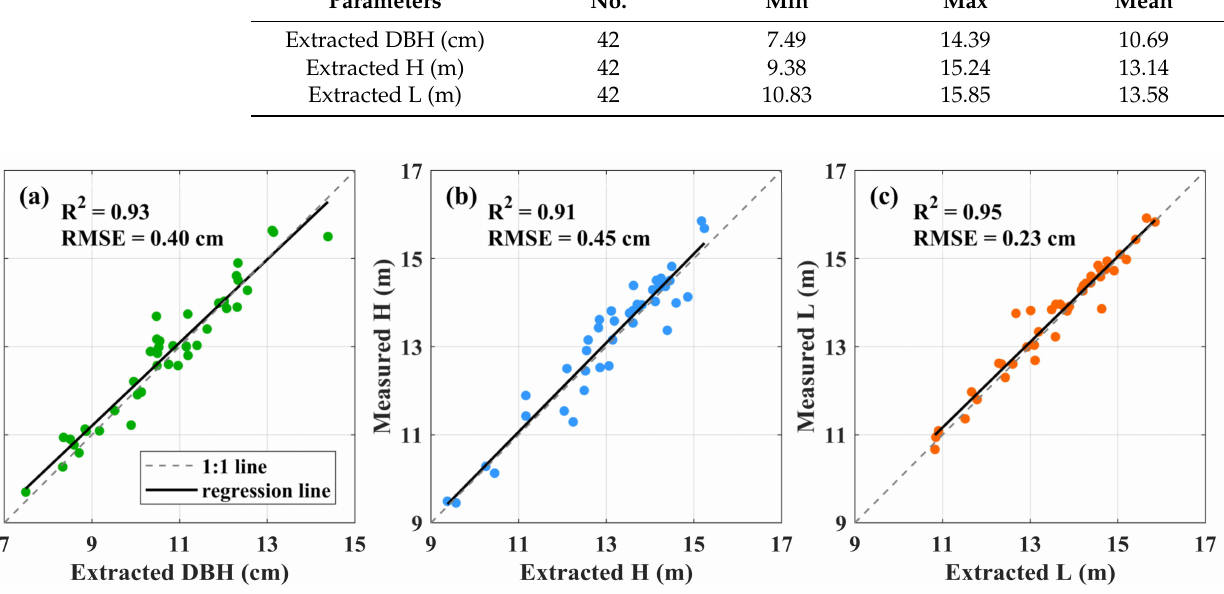
Figure 9. Accuracy assessment of extracted structural parameters of individual Moso bamboos: ( a ) DBH; ( b ) H; ( c )